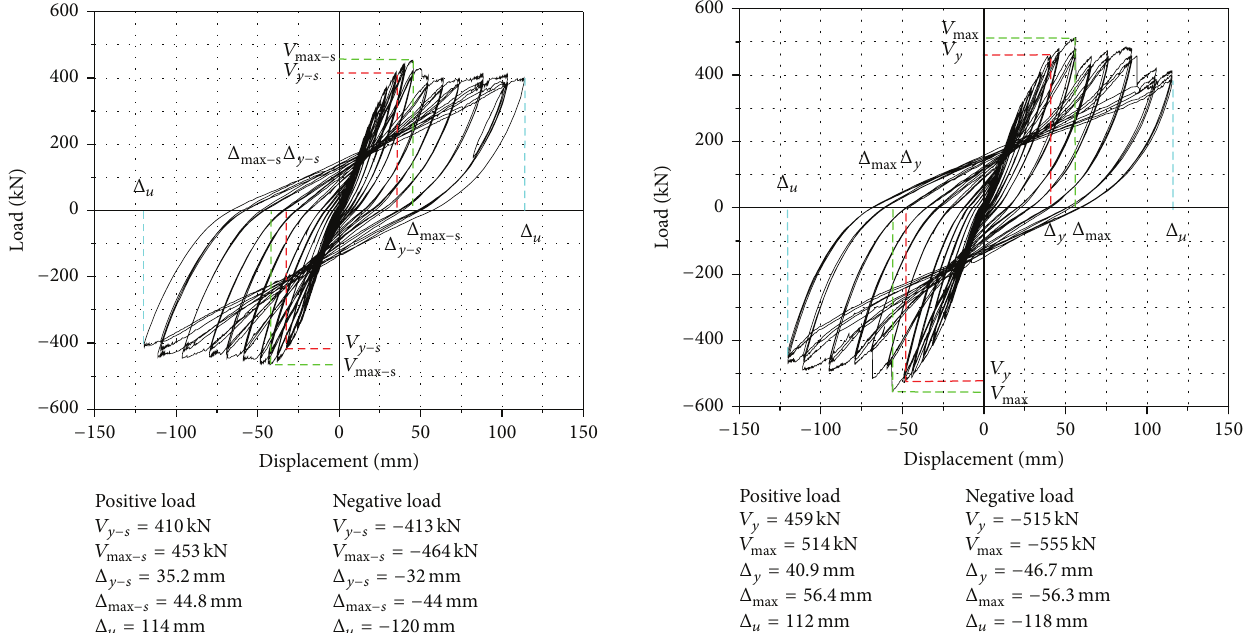
Figure 10: The lateral load-displacement curve for the SF-R1 specimen.